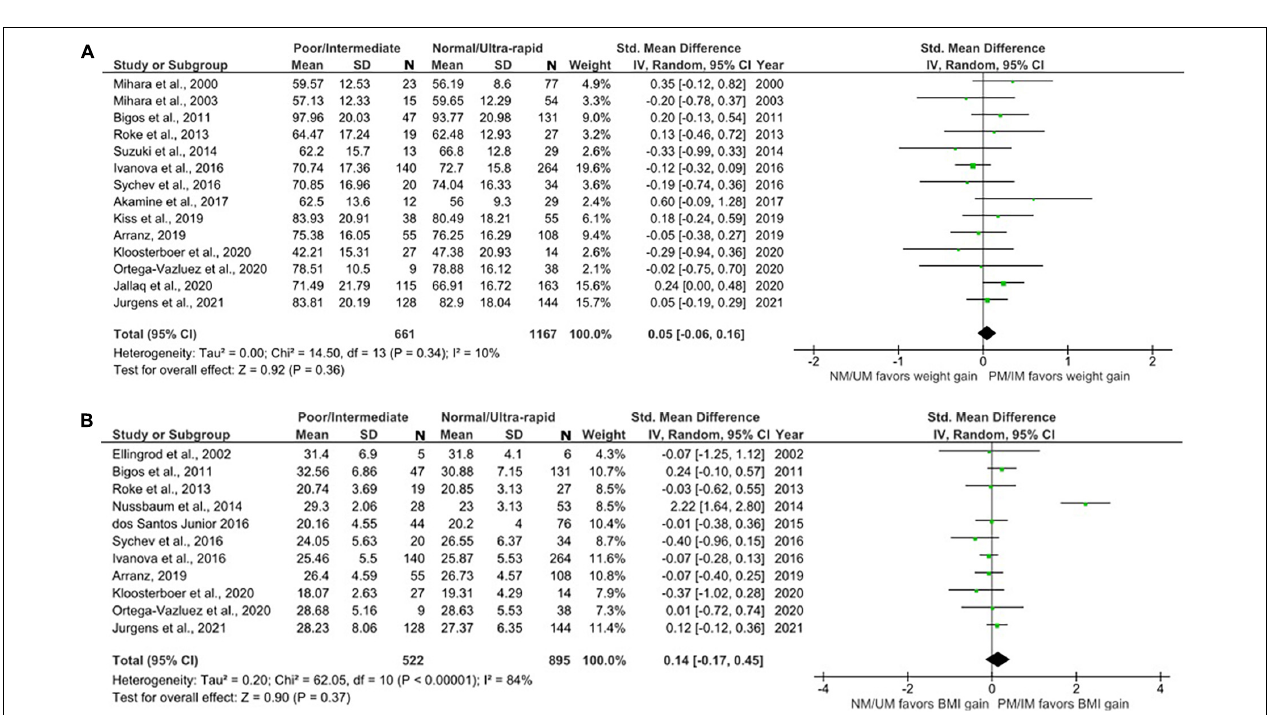
FIGURE 4 | Forest plots comparing (A) standardized mean weight differences (B) standardized mean BMI differences between Ultra-rapid metabolizers and Normal metabolizers. Random effects model and inverse variance method were use. CI, confidence interval; df, degree of freedom; N, number of participants; SD, standard deviation; SMD, standardized mean